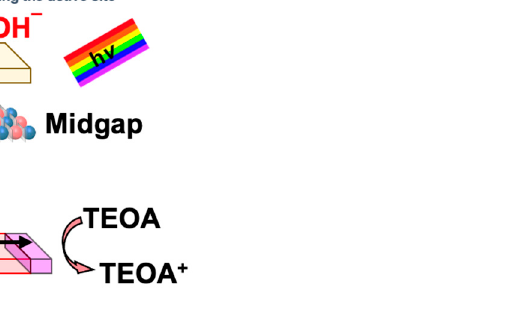
Table 5. The optimum conditions for HER via numerical optimization.